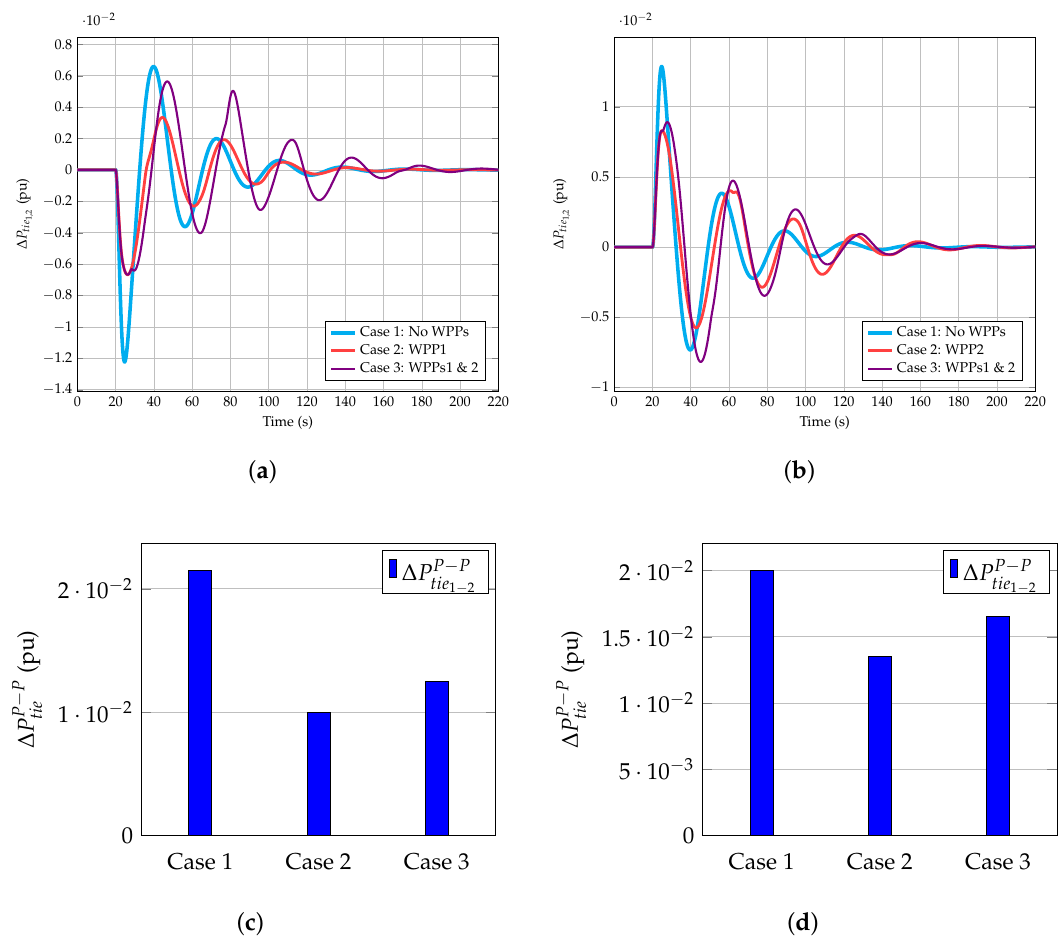
Figure 11. Active tie-line power evolution: comparison of ∆ P L ,1 and ∆ P L ,2 scenarios. ( a ) Area 1 submitted to power imbalance ( ∆ P L ,1 ); ( b ) Area 2 submitted to power imbalance ( ∆ P L ,2 ); ( c ) Area 1 submitted to imbalance ( ∆ P L ,1 ); ( d ) Area 2 submitted to imbalance ( ∆ P L ,2